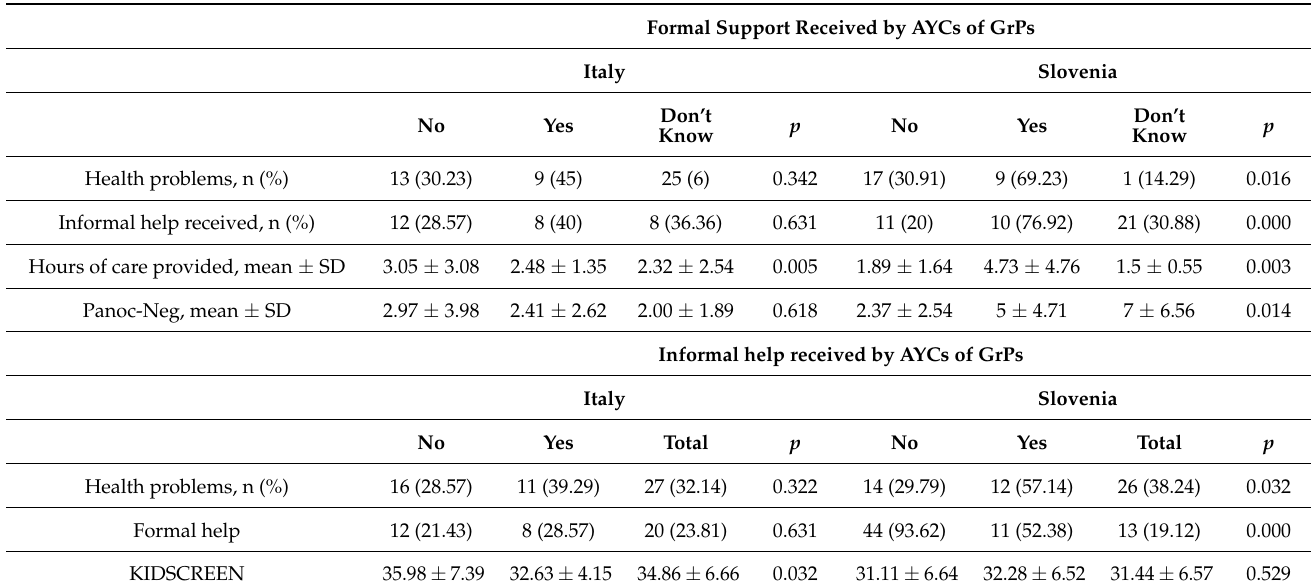
Table 3. AYCs’ condition by formal support